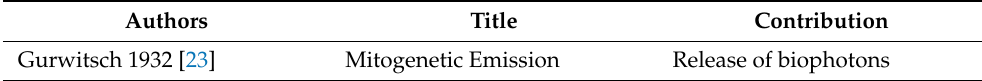
Table 1. Seminal studies informing on changes in the light therapy